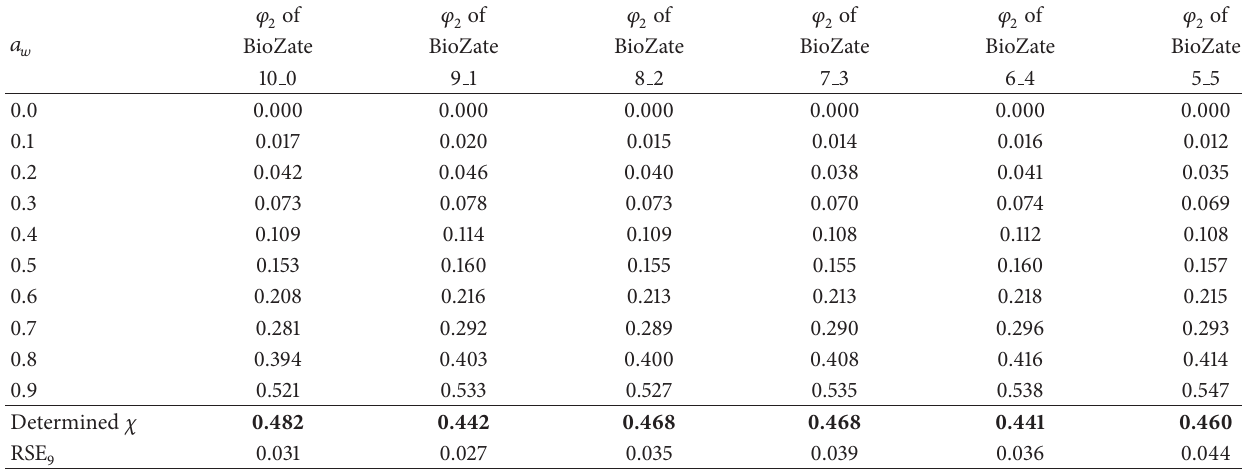
Table 2: Volume fraction of water ( 𝜑 2 = 1 − 𝜑 1 ) in the WPI-based films at different water activities and the resulting 𝜒 .